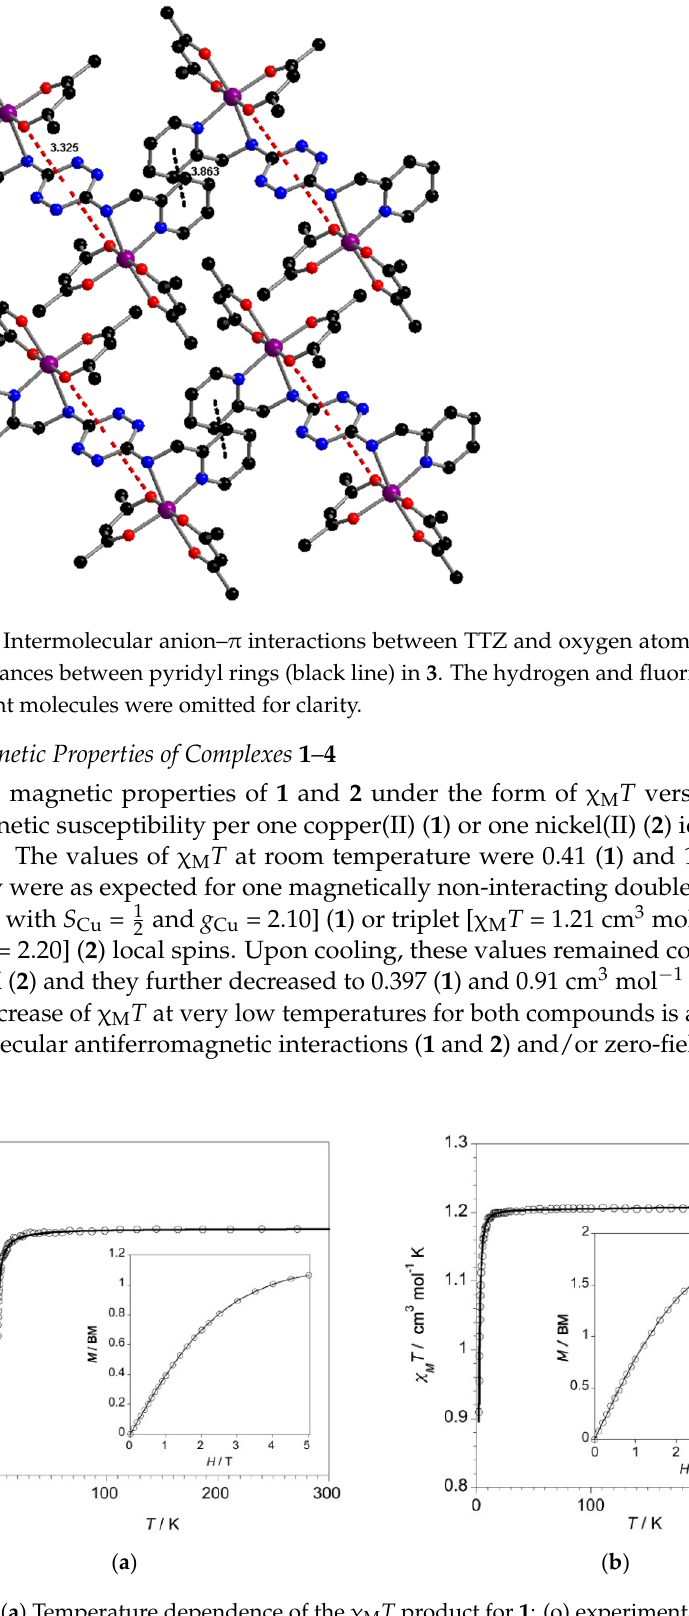
Figure 5. ( a ) Temperature dependence of the χ M T product for 1 : (o) experimental, ( __ ) best-fit curve through Equation (1) (see text). ( b ) χ M T against T plot for 2 : (o) experimental, ( __ ) best-fit curve through Equations (2–4) (see text). The inset shows the magnetization versus H plot for 2 at 2.0 K. The solid line is a guide for the eye.